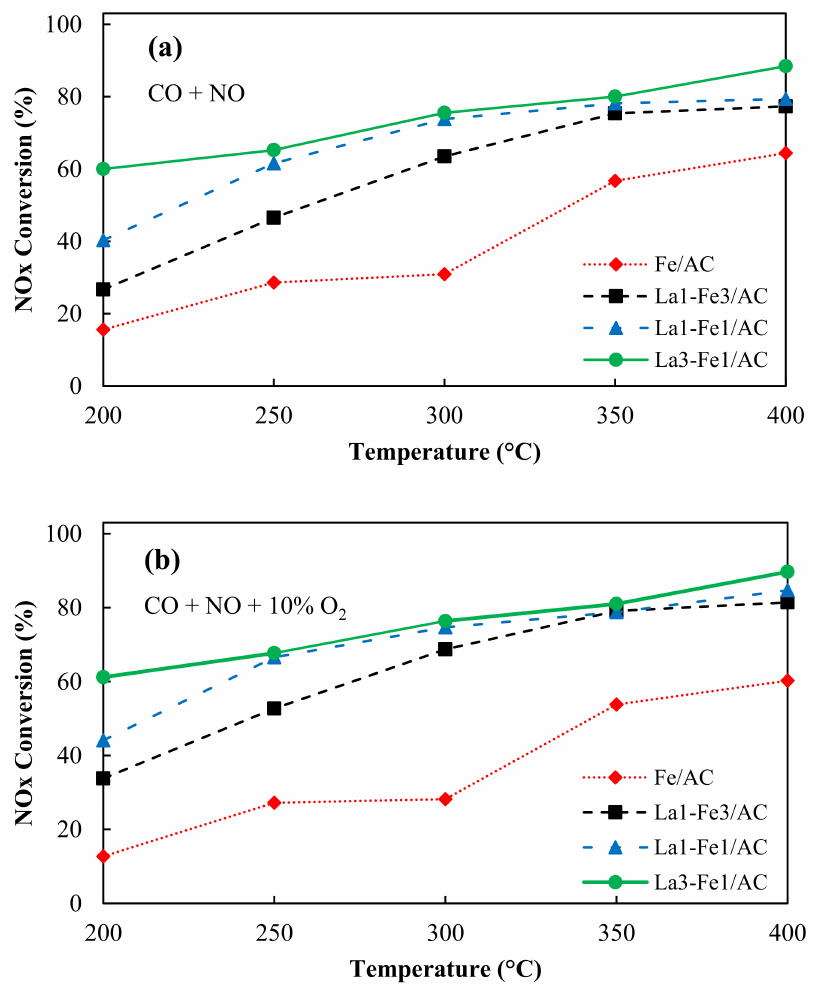
Figure 7. NO x conversion over La-Fe / AC catalysts ( a ) in the absence of oxygen and ( b ) in the presence of oxygen, reaction conditions: NO = 250 ppm, CO = 5000 ppm, total flow rate: 350 mL / min; temperature: 200–400 ◦ C, catalyst: 200 mg, GHSV = 26,000 h − 1